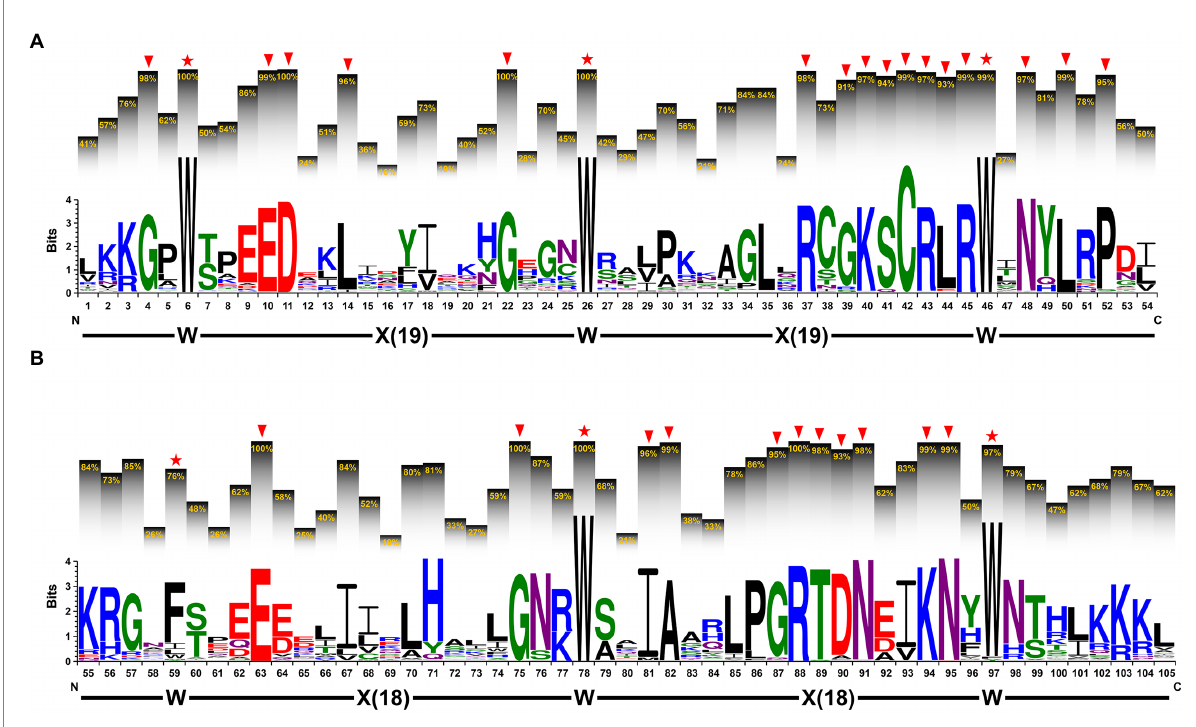
FIGURE 4 The sequence characteristics of the R2 and R3 MYB repeats. (A) The sequence logo of the R2 MYB repeat and (B) the R3 MYB repeat. The letters within each stack represent different amino acids and their height indicates the relative frequency of each amino acid at the respective position. The percentage on the histograms show the frequency of the highest conserved amino acid within each stack. The red stars indicate the conserved the highly conserved tryptophan (W) or the relatively conserved phenylalanine (F). The arrows indicate the highly conserved amino acids with frequency greater than